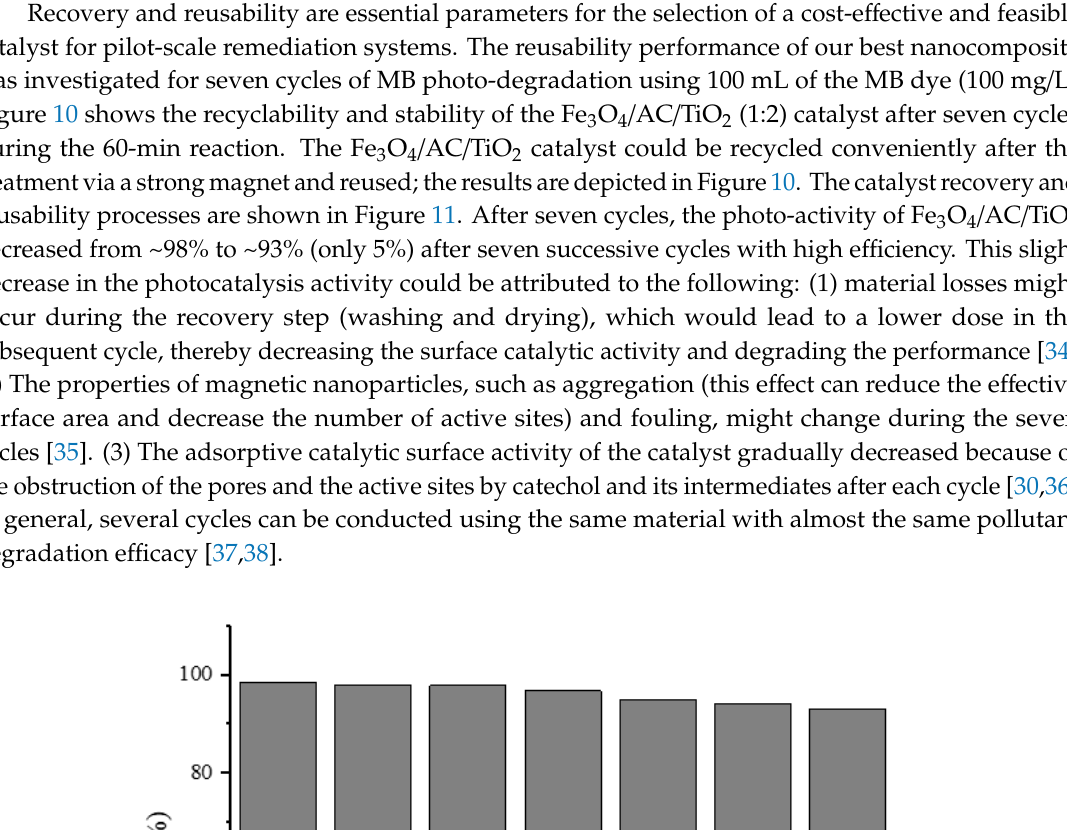
Figure 11. Recovery methodology after the photo-catalytic treatment of the pollutant solution. 5. Conclusions Coconut shell AC and magnetic Fe 3 O 4 /AC/TiO 2 have been synthesized in this work. The samples were characterized via different techniques. All the synthesised samples showed higher degradation efficiency under UV light than commercial TiO 2 , in particular, Fe 3 O 4 /AC/TiO 2 (1:2) presented the highest degradation rate of 98% in 60 min. The simple synthesised coconut shell AC showed high adsorption efficiency (76.2%) and could be used with the TiO 2 photo-catalyst to enhance the TiO 2